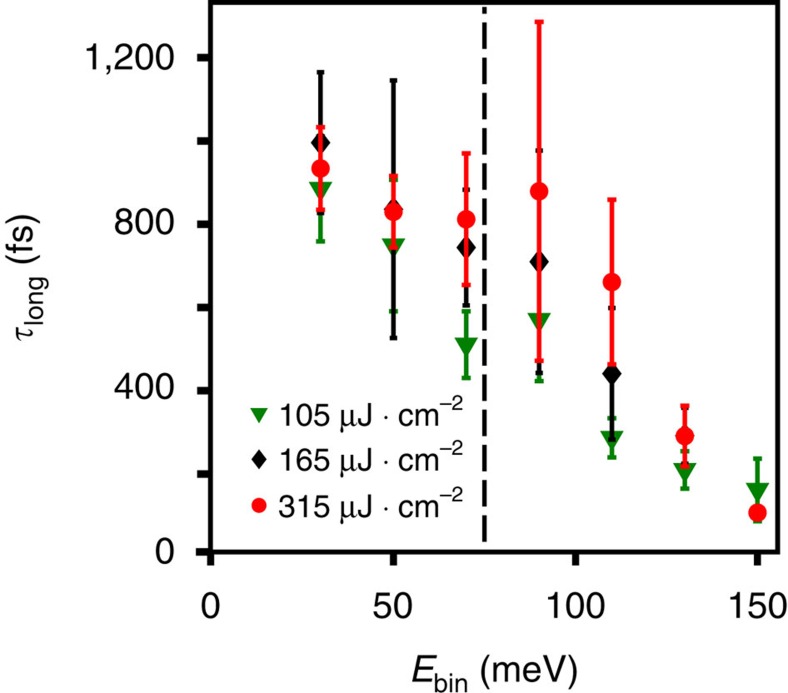
Experimental fluence and energy dependence of τlong. versus Ebin, as defined in the main text, for Φ=105 (green) 165 (black) and 315 (red) μJ·cm−2. The vertical dashed line at 75 meV denotes the theoretical position of +ħΩ.